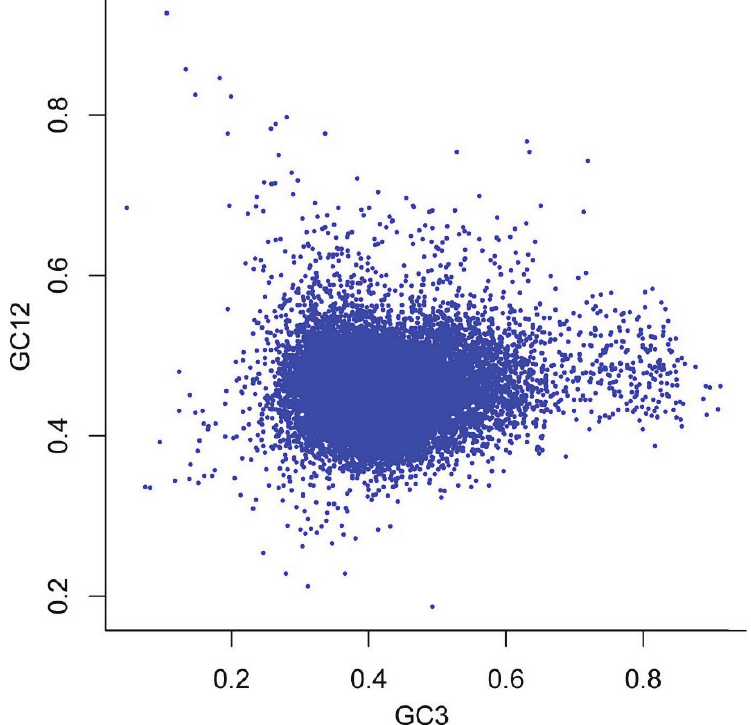
Figure 2. Neutrality plot (GC12 vs .